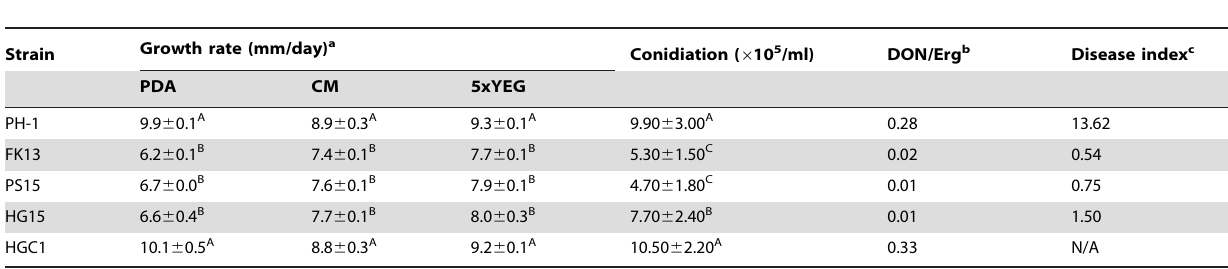
a Growth rate and conidiation were measured after incubating for 3 and 5 days, respectively. Mean and standard deviation were calculated from three replicates. The same letter indicated there was no significant difference. Different letters were used to mark statistically significant differences (P=0.05). b DON/Ergosterol ratio was determined with 2-week-old rice grain cultures. Ergosterol was measured to quantify fungal biomass. c N/A, not assayed. suggest that the FgHog1 MAPK pathway also is involved in responses to oxidative and cytoplasm membrane stresses in F. graminearum .